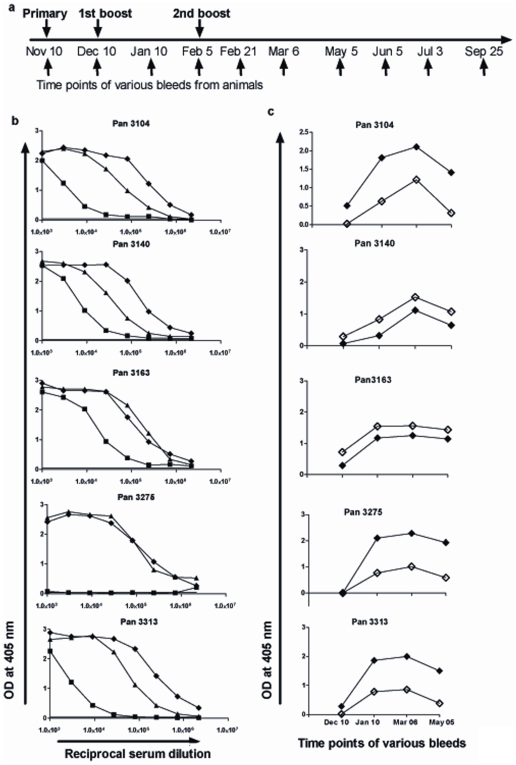
Analysis of anti-Pfs48/45 antibody production by Olive baboons (Papio anubis).(a) Each animal was immunized with CH-rPfs48/45 (50 µg in 0.25 ml endotoxin free PBS) formulated in Montanide ISA-51 (0.25 ml) in baboons, administered intra muscularly (quadriceps, two sites). Schedules for immunization and bleeds are indicated and sera were stored at −20°C until shipped frozen from Kenya to Baltimore for ELISA and MFA. The samples were shipped under an export permit CITES # 008101. (b) Anti-Pfs48/45 whole IgG titer at various time points analyzed by ELISA. Pre-immune +3 x SD is shown by solid horizontal lines. ELISA readings with sera dilutions, 1 month post primary immunization (filled square), 1 month post first boost (filled triangle) and 1 month post second boost (filled diamond) are shown with±SD for individual baboons (Pan 3104, Pan 3140, Pan 3163, Pan 3275, Pan 3313). (c) Distribution of anti-Pfs48/45 IgG1(solid diamonds) and IgG2 (open diamonds) subtypes in 1 month post primary immunization sera (Dec 10), 1 month post 1st boost (Jan 10), 1 month post 2nd boost (Mar 06), and 3 months post 2nd boost (May 05). Data are presented as mean OD405 value±SD for individual baboon.